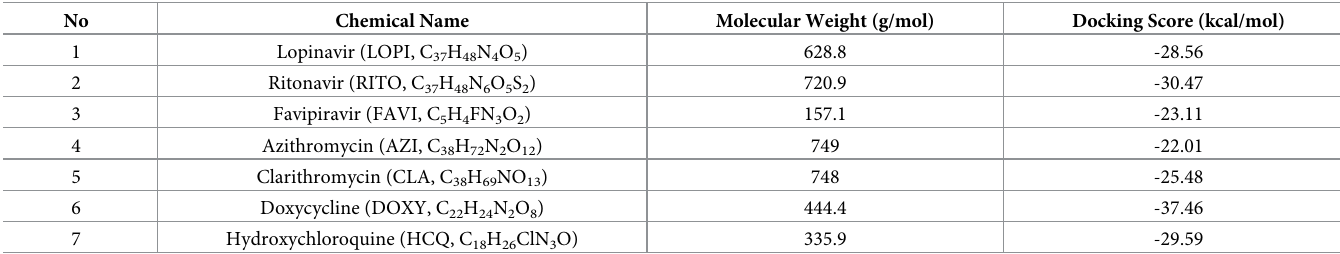
Table 6. The docking scores of potential SARS-CoV-2 main protease inhibitor